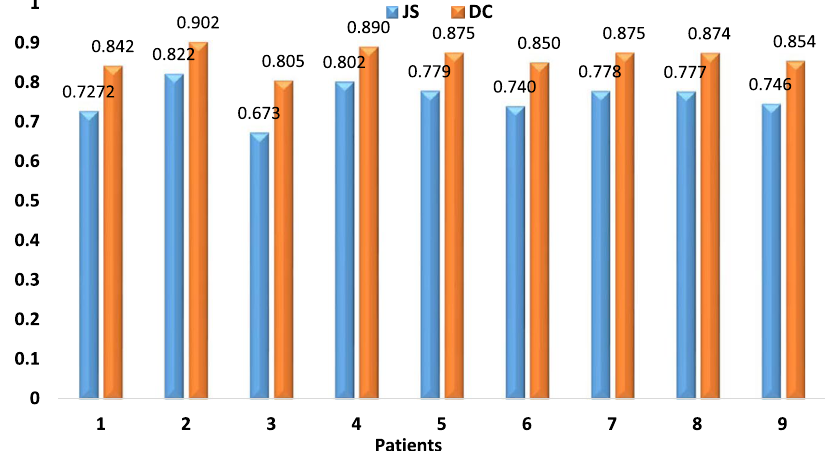
Figure 8. Evaluation results of the proposed method on the 9 LGG patients under study using JS and DC.